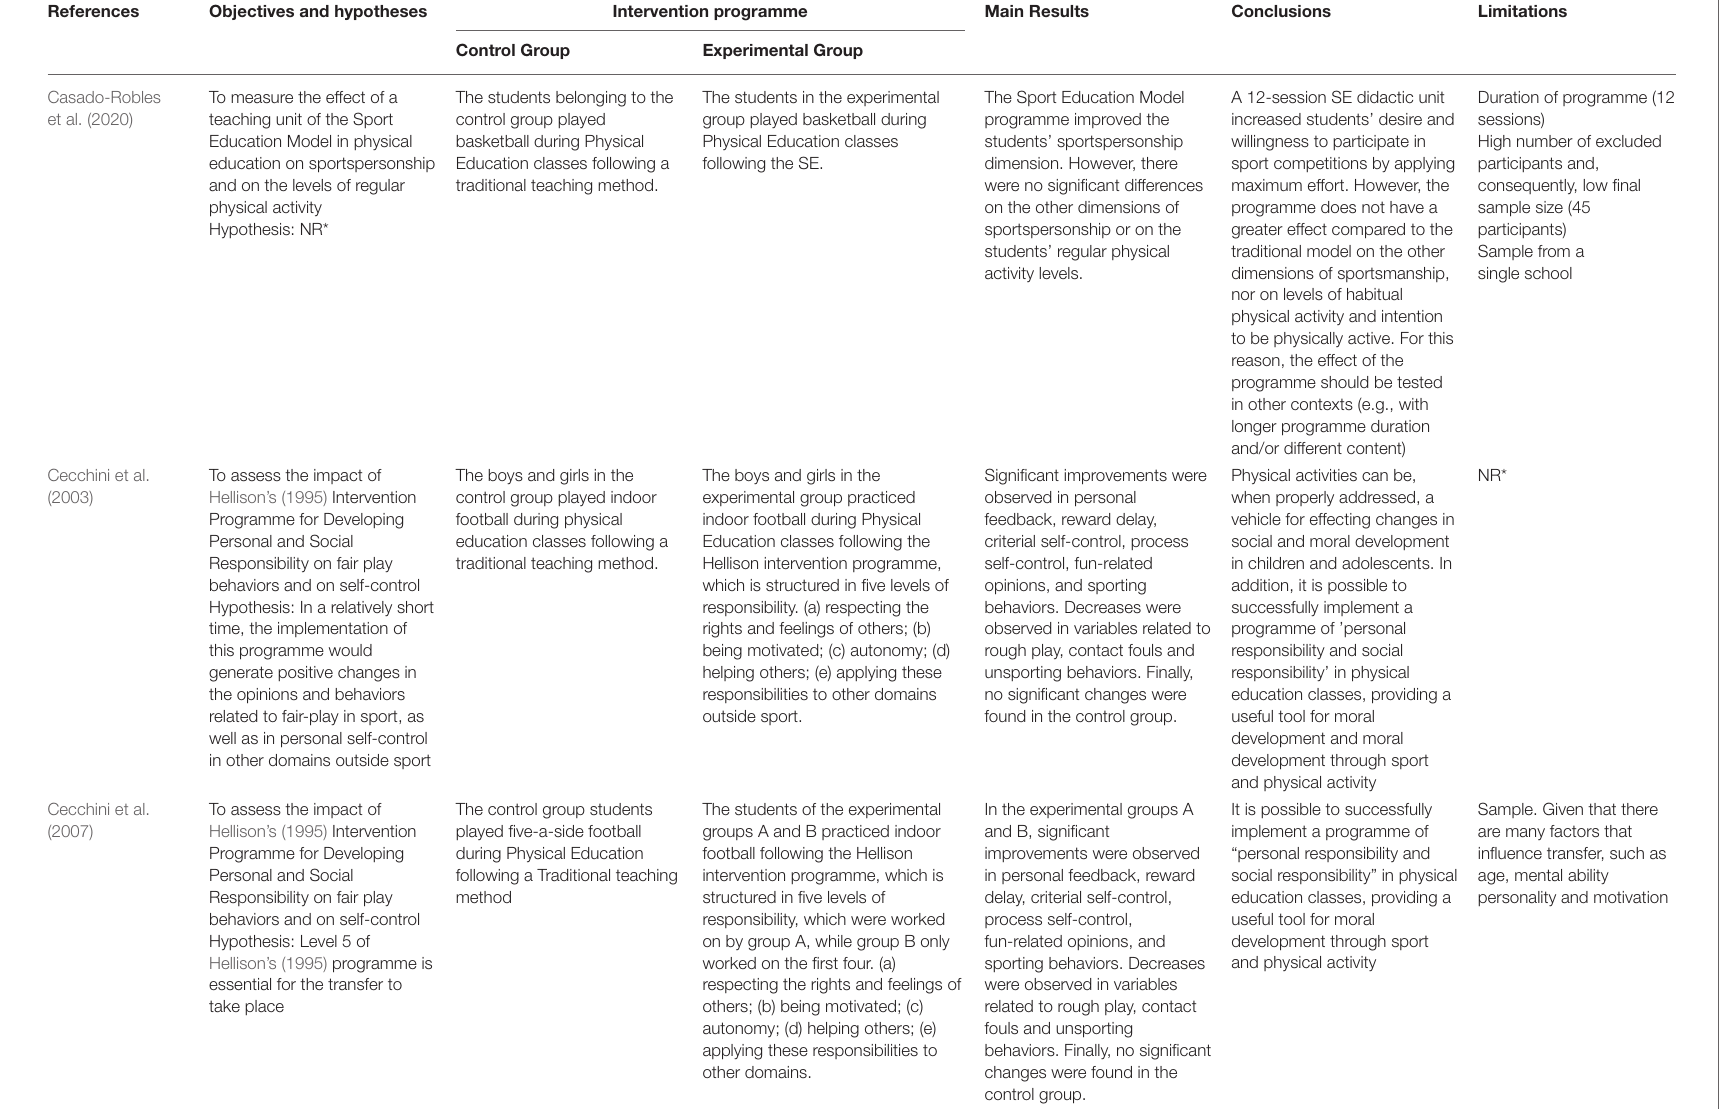
TABLE 3 | Objectives, intervention programme, main results, conclusions, and limitations of the research included in the systematic review and